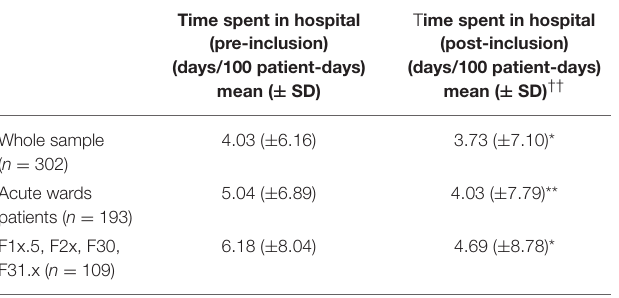
TABLE 2 | Number of days spent in the hospital before and after inclusion in the model project.